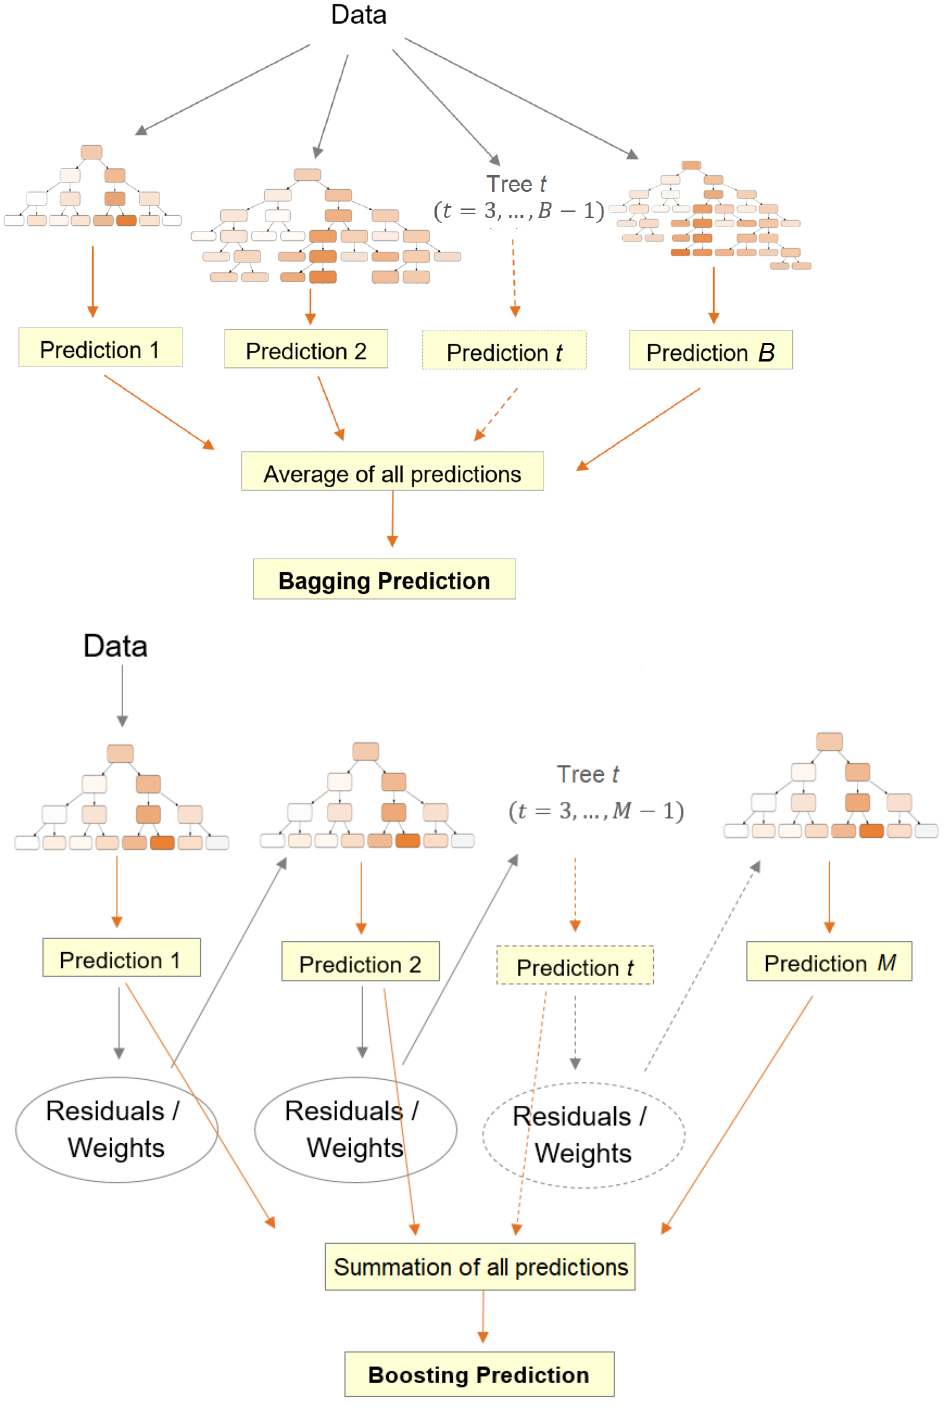
Figure 2. Diagrams of bagging and boosting